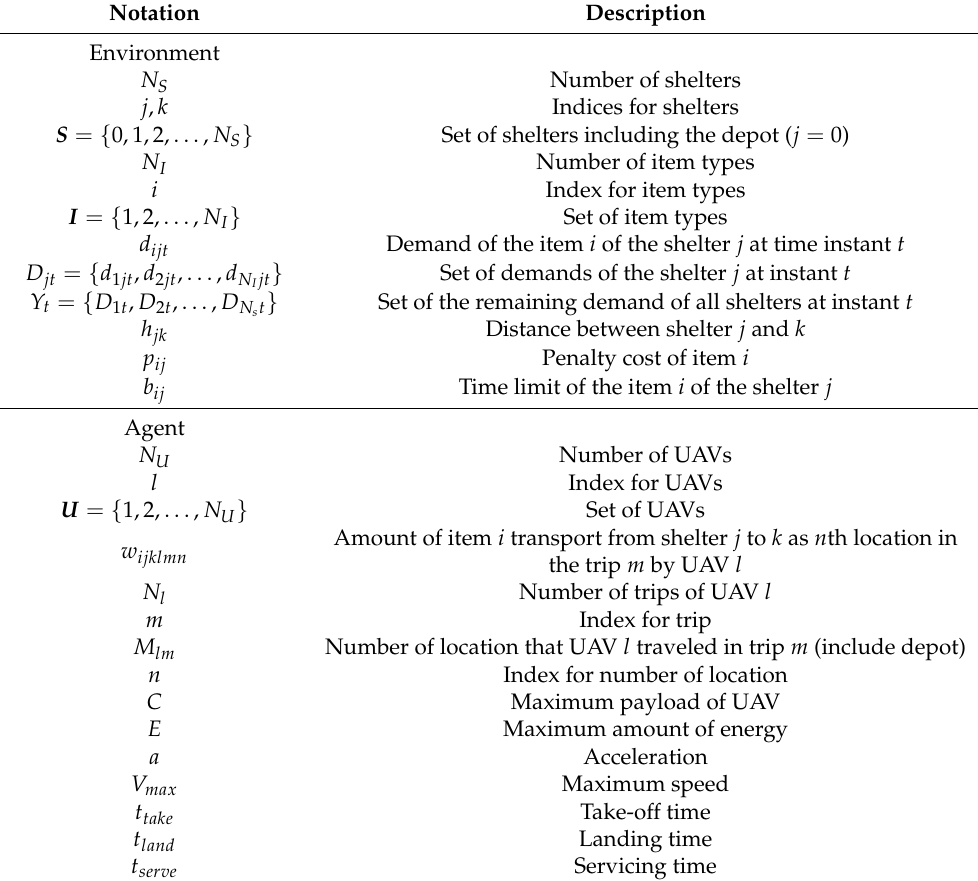
Table 1. Notations